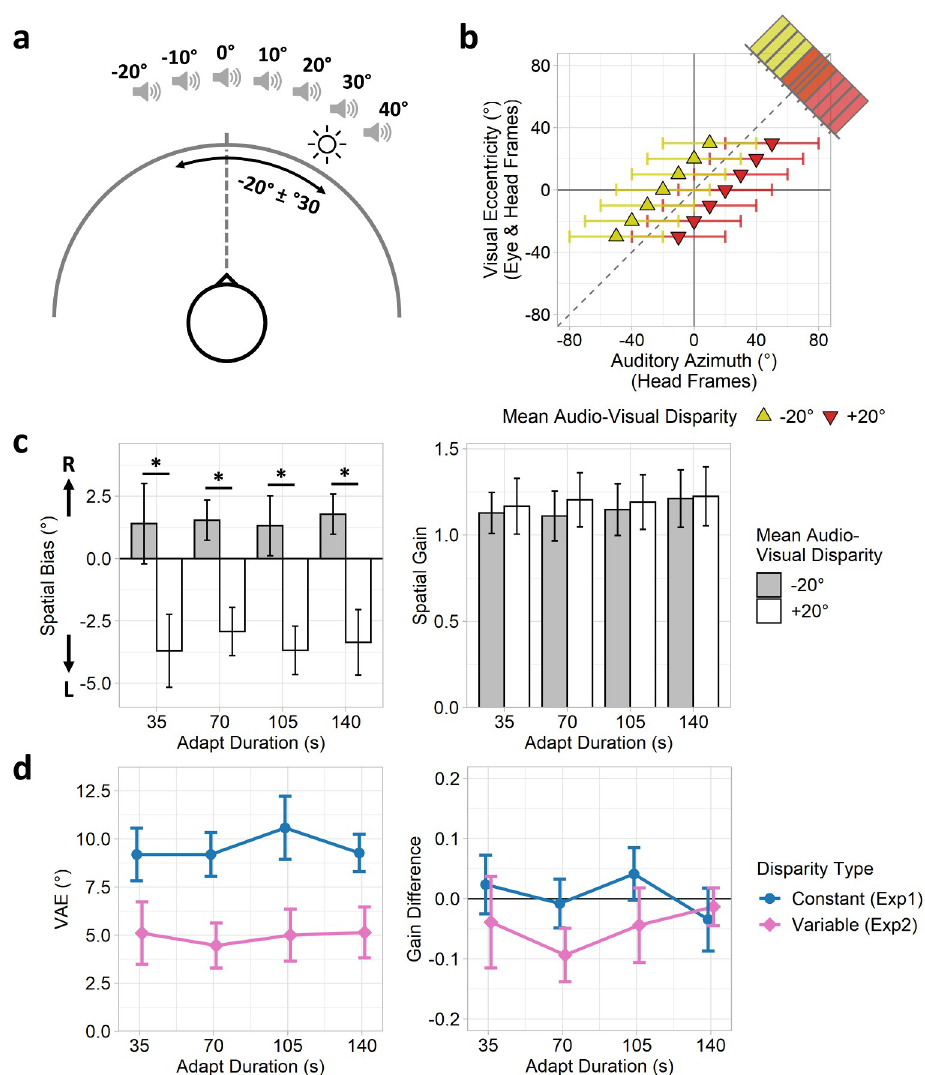
Fig 3. Experiment 2: Design, and group spatial bias and gain estimates. (a) Schematic illustration of an example trial pairing a visual stimulus at +30˚ eccentricity with an auditory stimulus positioned ± 30˚ of an average -20˚ leftward offset. (b) Auditory azimuth plotted against visual eccentricity. Eye- and head-centred visual signals yield equivalent audio-visual disparities but which vary over trials. Markers and error bars indicate means and ranges of possible auditory locations for each visual location. Corner histograms illustrate distributions of audio-visual disparities. (c) Spatial bias (intercept) and gain (slope) coefficients for each condition. Error bars indicate standard errors of the coefficients. (d) VAE magnitudes and gain differences, quantified by contrasting spatial bias and gain coefficients between adaptation disparities (-20˚ > +20˚). Values are shown for both constant (blue; Experiment 1: eye+head- consistent condition) and variable disparities (pink; Experiment 2). Positive VAE magnitudes indicate spatial recalibration in the direction of the mean visual offset. Error bars indicate standard errors of the mean.